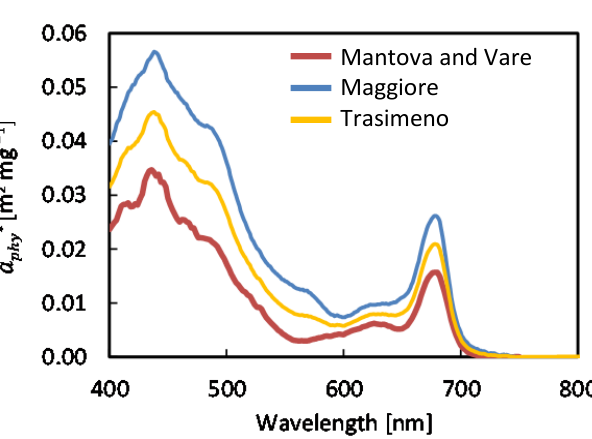
Figure 5. The specific absorption spectrum of phytoplankton a ∗